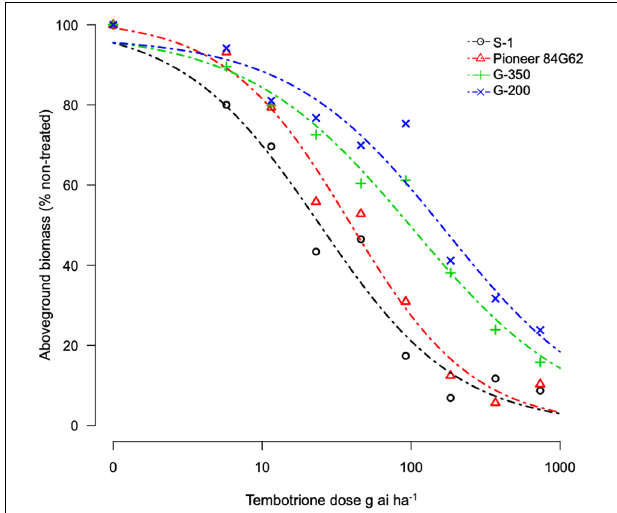
FIGURE 1 | Tembotrione dose-response curves obtained by non-linear regression analysis of above-ground dry biomass of S-1 (susceptible), Pioneer 84G62 (commercial hybrid), G-200, and G-350 (resistant) using the three-parameter log-logistic model.